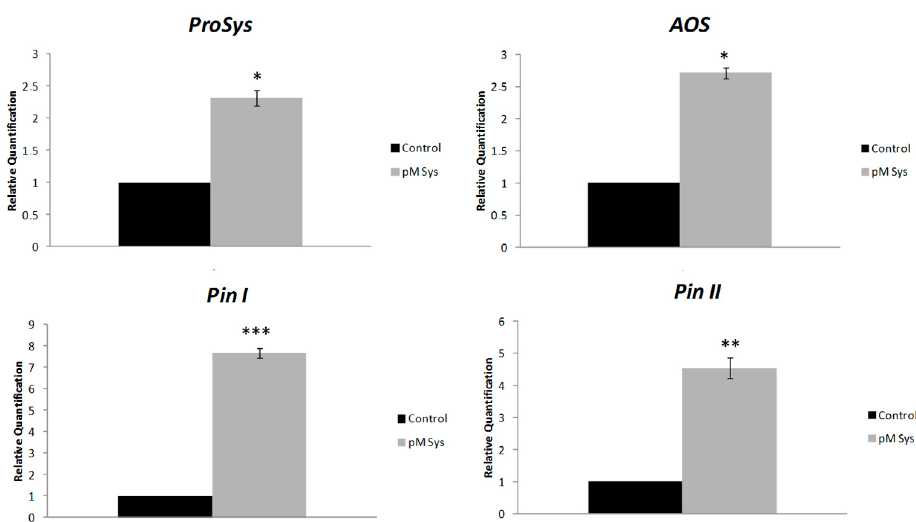
Figure 9. Gene expression in plants grown in hydroponic solution containing Sys. Quantification of transcripts of ProSys, AOS, Pin I and Pin II by Real Time RT-PCR detected in leaves of plants grown in a hydroponic system, 3 h after the addition of 100 pM systemin. Relative quantities are calibrated on samples obtained from tomato leaves of plant grown in a hydroponic system supplied with PBS1X. Asterisks denote statistically significant di ff erences (* p < 0.05, ** p < 0.001, *** p < 0.0001; T-test). Error bars indicate standard